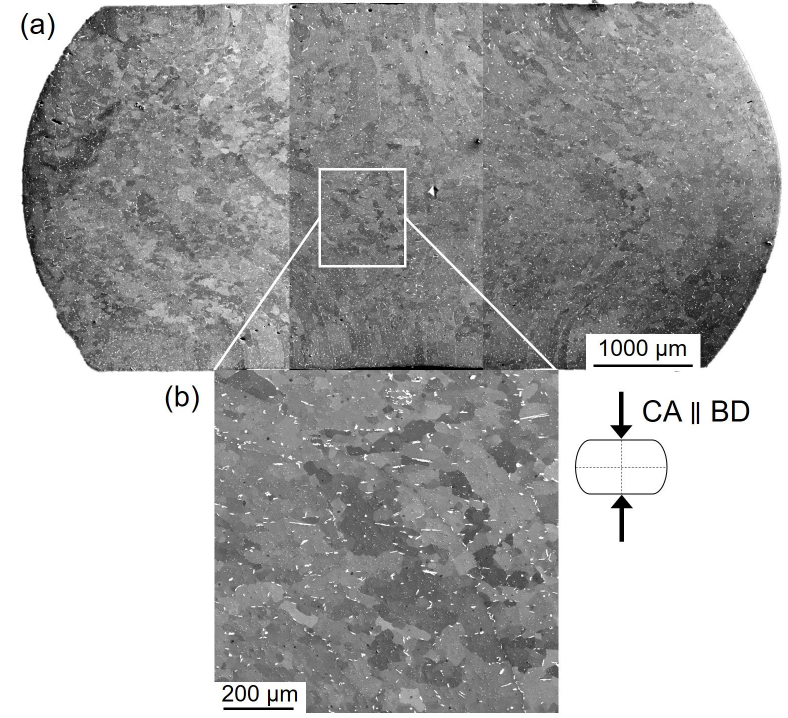
Figure 3. Typical SEM ‐ BSE micrographs of the LPBF ‐ fabricated Fe ‐ 25Al ‐ 1.5Ta specimen hot com ‐ pressed at 1000 °C/0.0013 s − 1 up to a true strain of 0.8 parallel to the BD. The micrograph in ( b ) shows a high ‐ resolution image of the central region of the specimen marked by a white rectangle in ( a ). The white ‐ contrast regions represent (Fe, Al) 2 Ta C14 Laves phase precipitate particles. CA and BD refer to the compression axis and building direction in the LPBF process, respectively. CA is parallel to the BD.